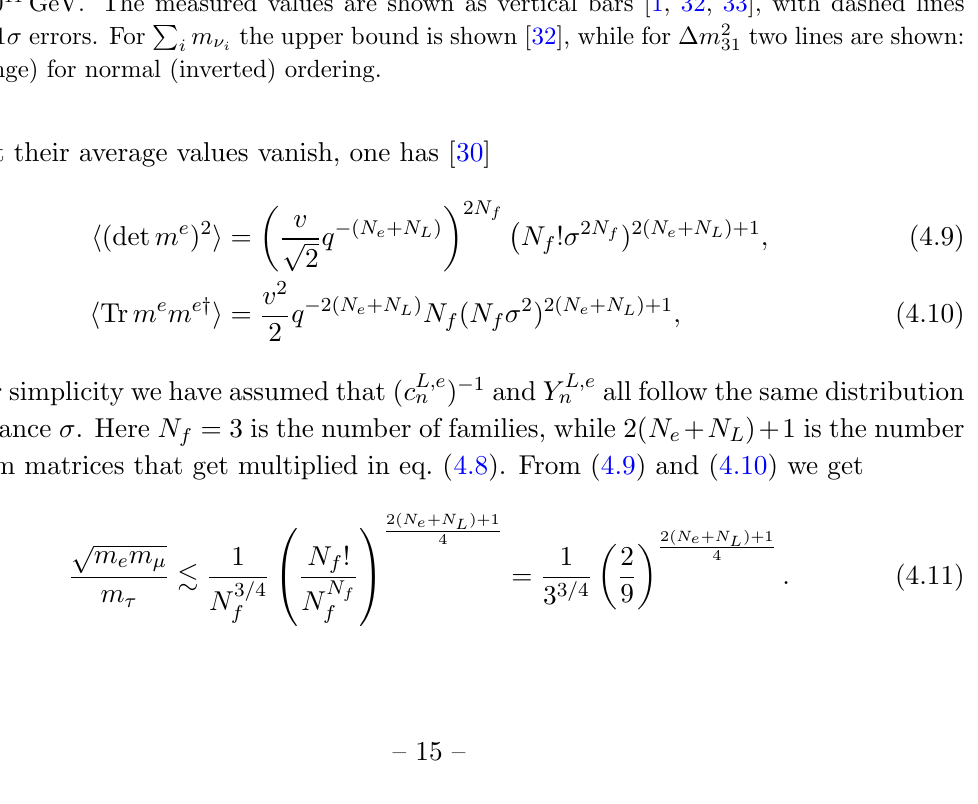
, 12 , setting FN two lines are shown: 31